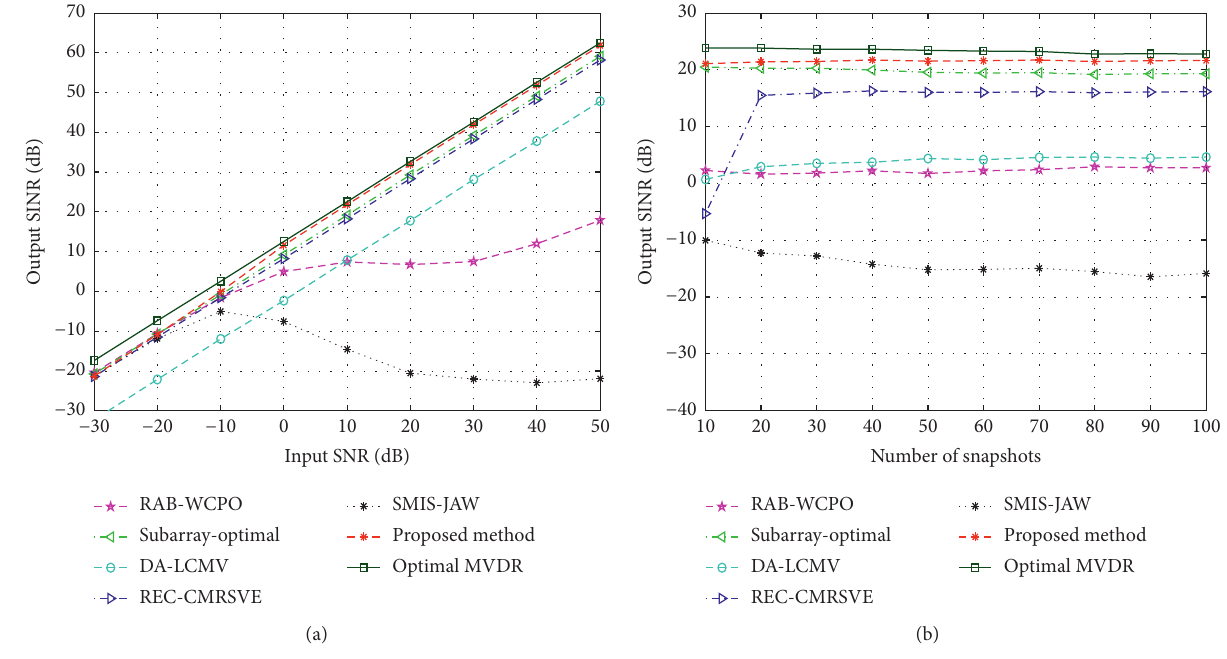
Figure 8: Fifth example: (a) output SINR versus input SNR and (b) output SINR versus number of snapshots.